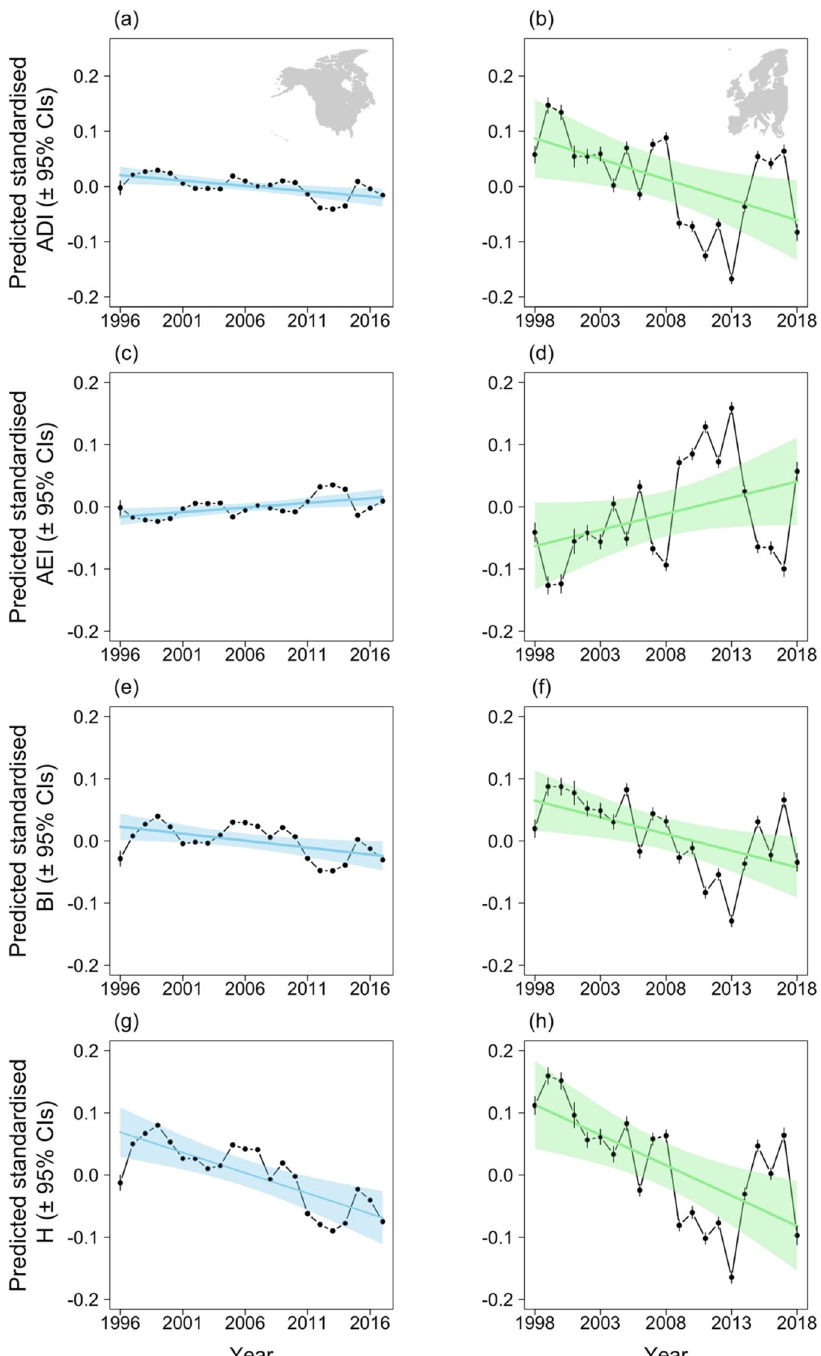
Fig. 3 Temporal trends in acoustic indices. Predicted annual variation in Acoustic Diversity Index, ADI ( a , b ), Acoustic Evenness Index, AEI ( c , d ), Bioacoustic Index, BI ( e , f ) and Acoustic Entropy, H ( g , h ) in North America (left column) between 1996 and 2017 and in Europe (right column) between 1998 and 2018. Blue (North America) and green (Europe) lines show the predicted trends from GLMMs (Table 3); shaded areas indicate 95% con fi dence intervals. Points show predicted annual values from GLMMs with the identical structure as those in Table 3 but with year fi tted as a categorical rather than a continuous variable, vertical lines indicate the 95% con fi dence intervals. Annual values of each acoustic index were standardised at the site-level prior to